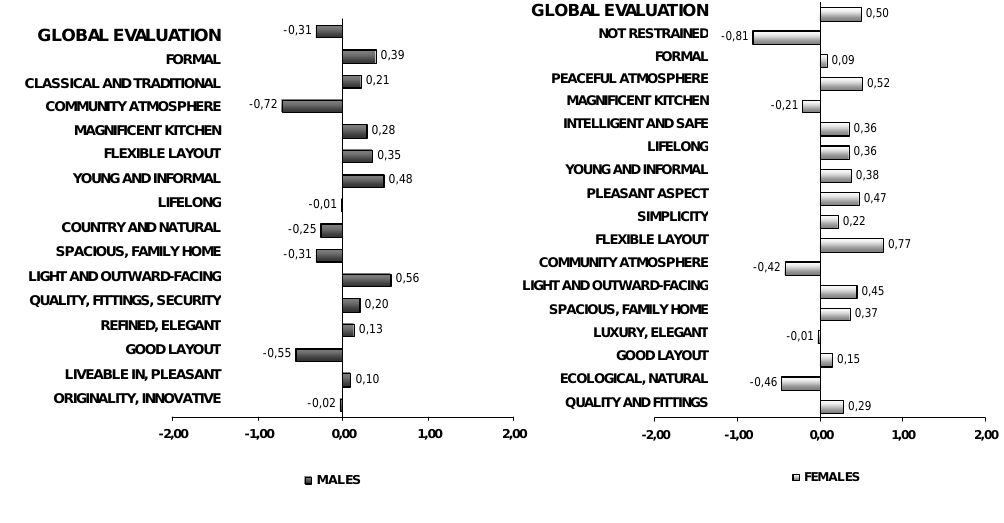
Figure 3. “Comparison of semantic profiles (Men-Women)”. Source: